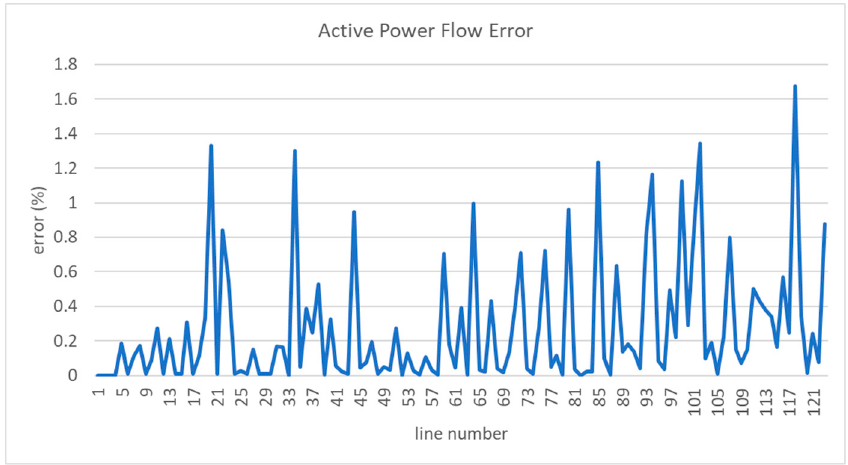
Figure 14. Active power flow error produced by the state estimator.